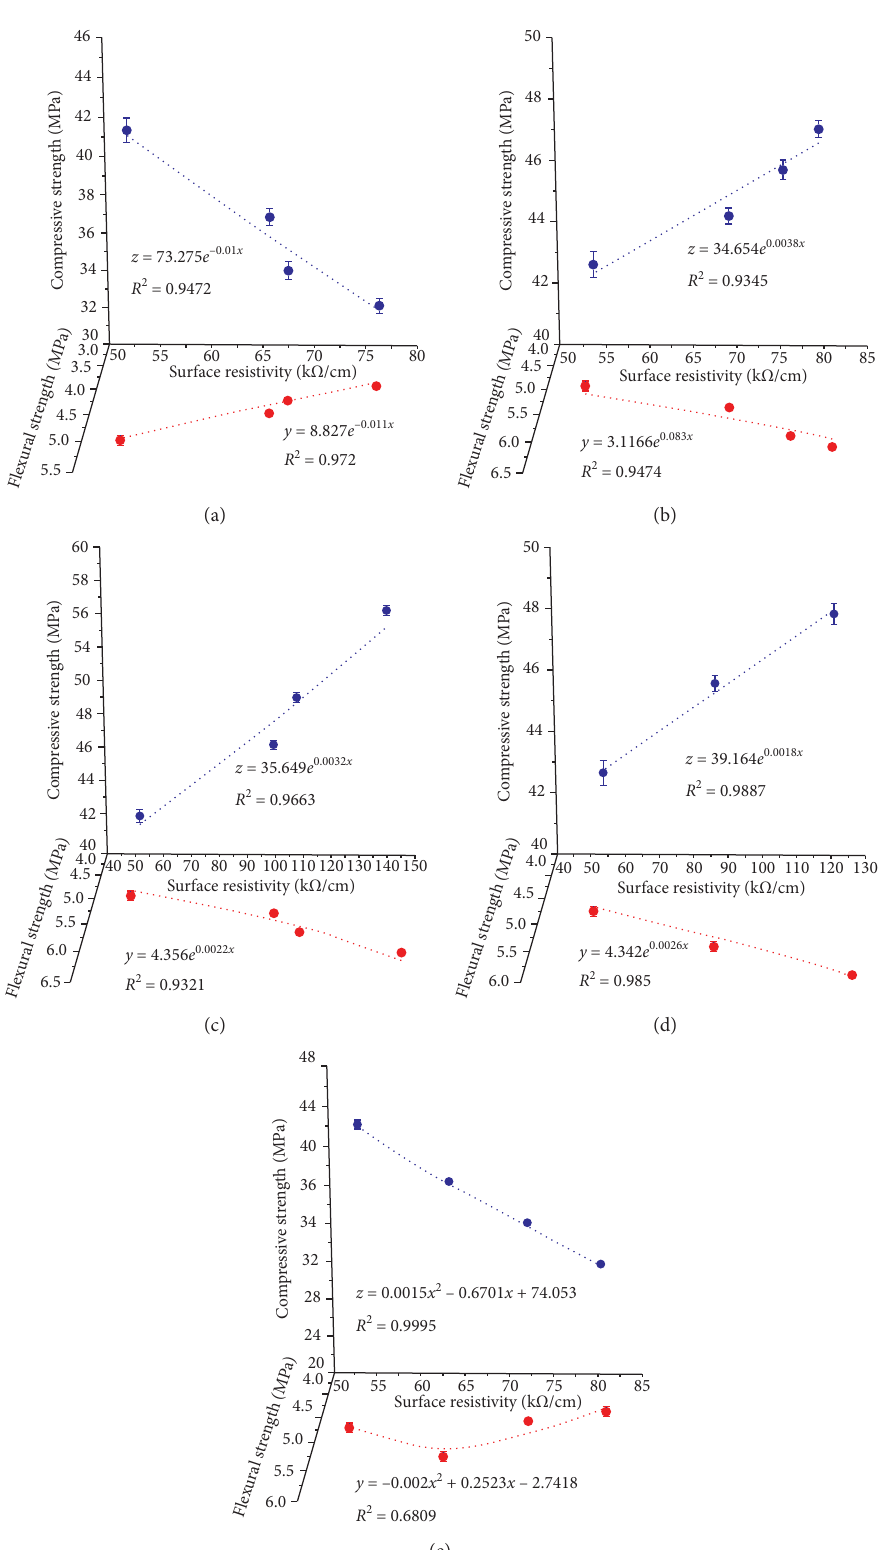
Figure 10: Correlation analysis between surface resistivity and mechanical properties. (a) FA. (b) BFS. (c) SF. (d) Multimineral admixtures. (e) Air